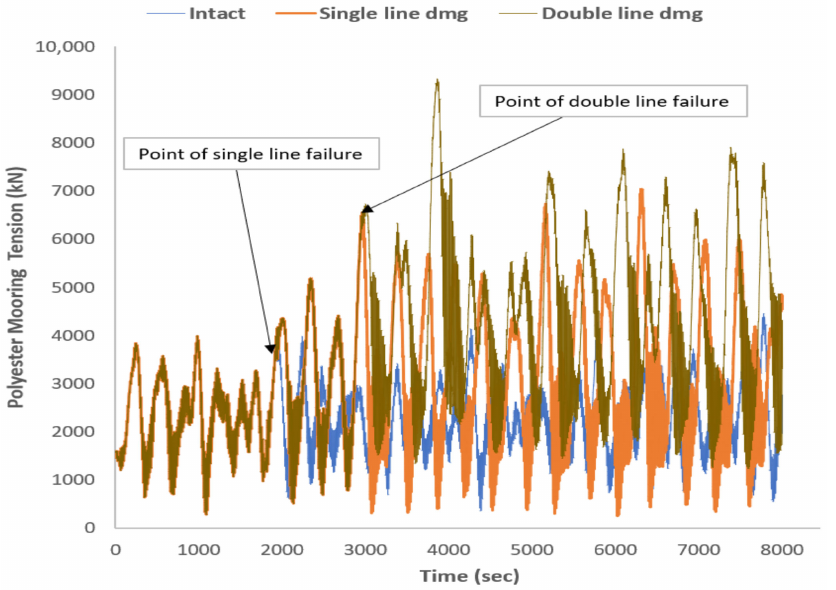
Figure 13. Comparison of polyester representative mooring line (line 7) in intact and damaged conditions.